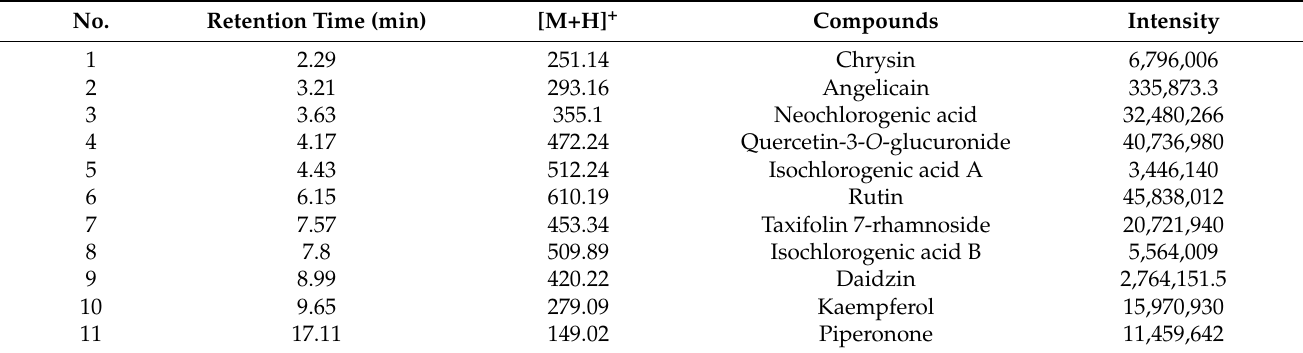
Table 3. Identification of the composition of LBLF.